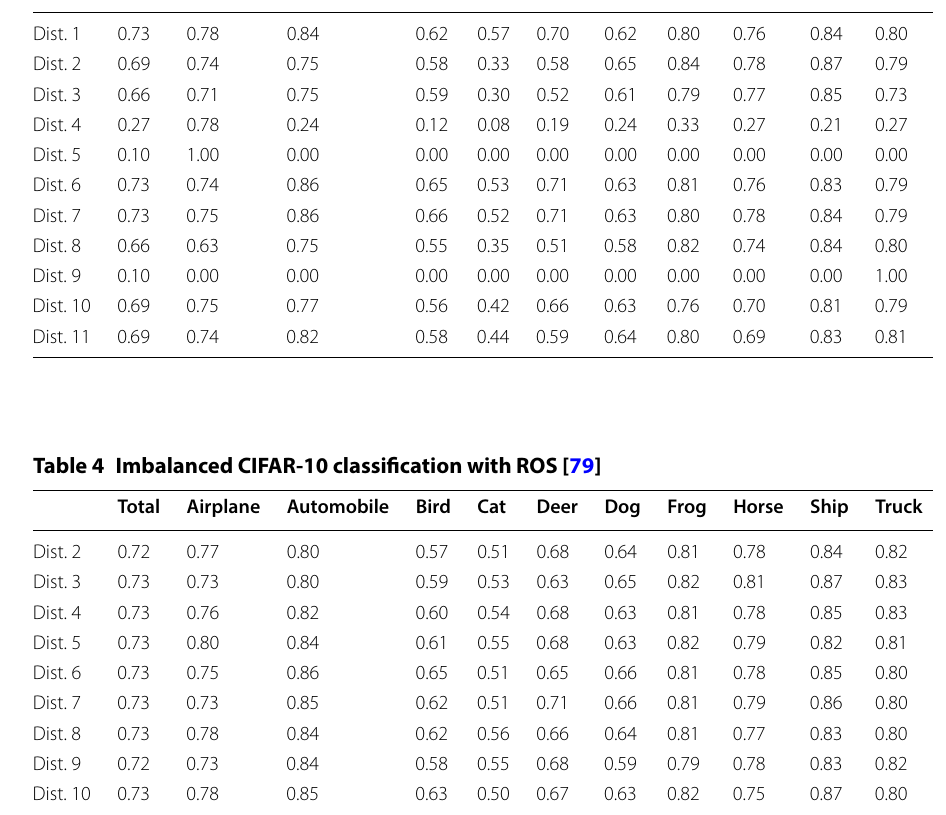
Table 3 Imbalanced CIFAR-10 classification [79] Total Airplane Automobile Bird Cat Deer Dog Frog Horse